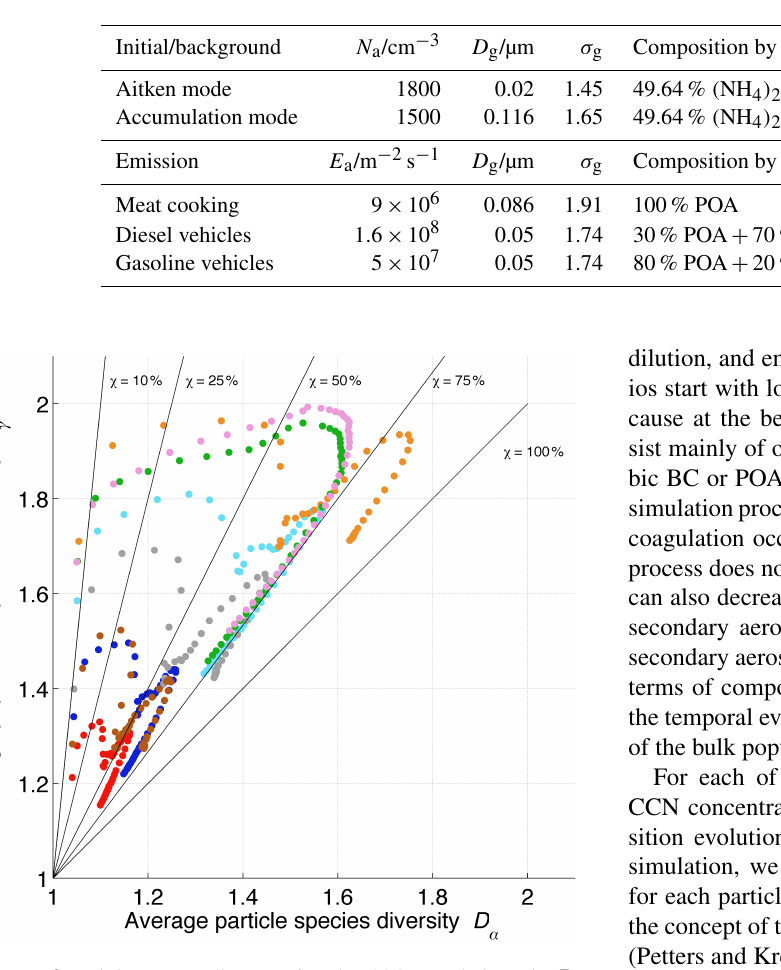
Figure 2. Mixing state diagram for the 384 populations in P . The colors indicate the Ching et al. (2016a) scenario from which the populations were sampled: B100-E100-G100 (light blue), B10-E100-G100 (orange), B100-E25-G100 (blue), B10-E25-G100 (grey), B100-E2.5-G100 (red), B10-E2.5-G100 (brown), B100- E100-G50 (green), and B100-E100-G25 (pink). The abbreviations of the scenarios follow Ching et al. (2016a), “B” indicates the level of background particle concentration (100 and 10% of the base case scenario), “E” indicates the level of the black carbon emission rate (100, 25, and 2.5% of the base case scenario), and “G” indicates the level of gas emission rate (100, 50, and 25% of the base case